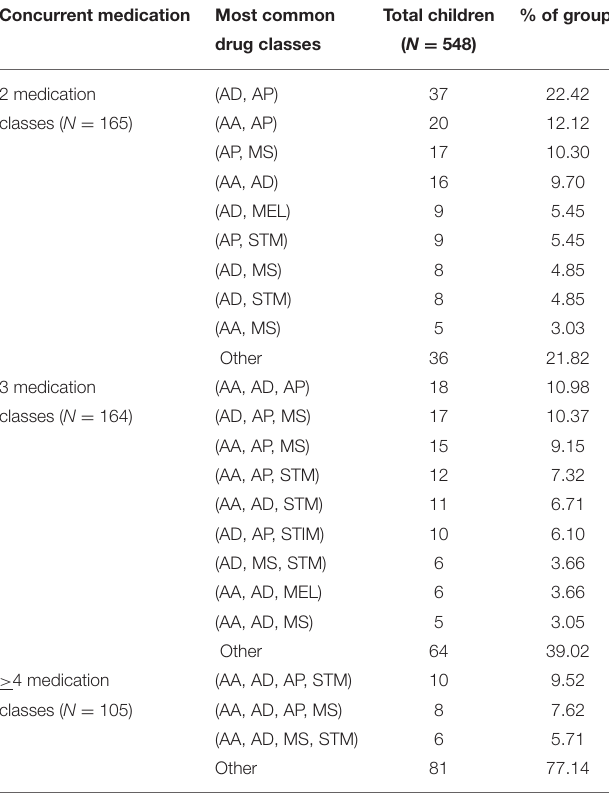
TABLE 4 | Most common drug classes in concurrent medications prescribed at discharge. Concurrent medication Most